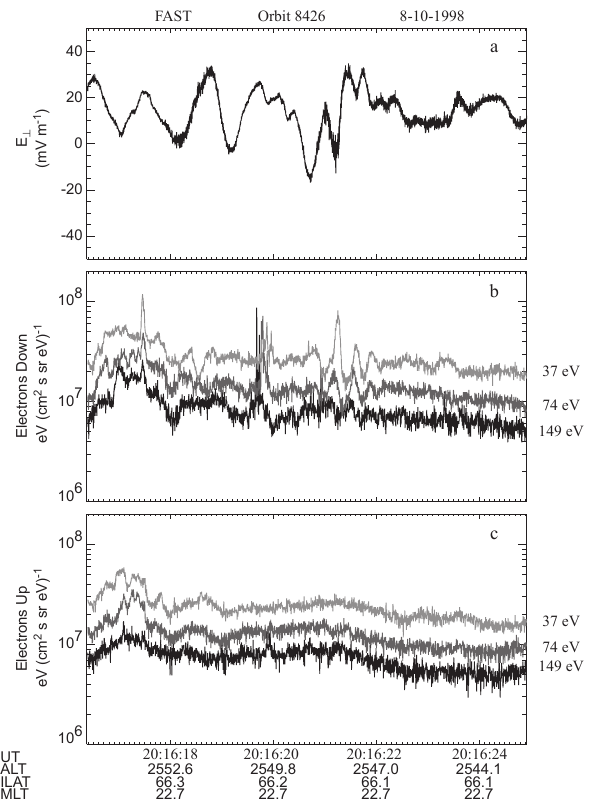
Fig. 1. The same as Fig. 2 in the paper by Robinson et al. (2000). FAST observations: (a) perpendicular component of dc electric field; (b) and (c) downward/upward electron fluxes in the 37, 74, 149 eV channels of the electrostatic analyzer, presented in the units Fig. 1 of fluxes multiplied by the central energy of the corresponding en- ergetic